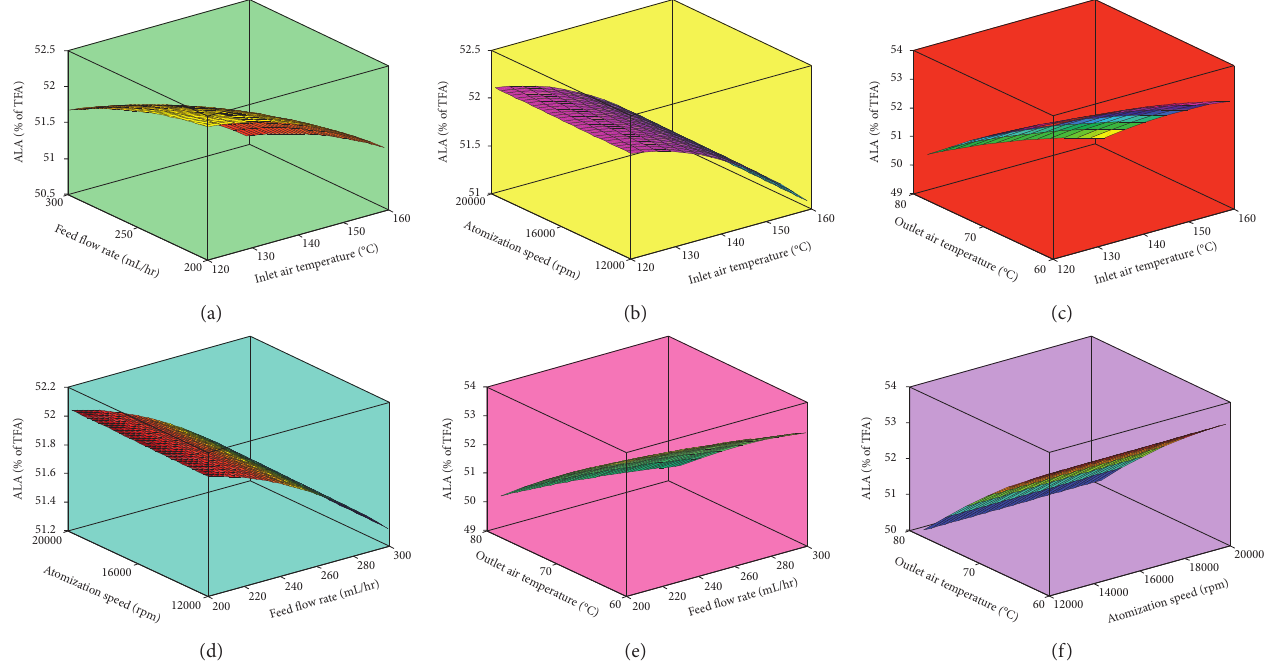
Figure 3: Response surfaces for the mutual interaction effect of spray-drying conditions on the alpha-linolenic acids (ALA) retention in flaxseed oil